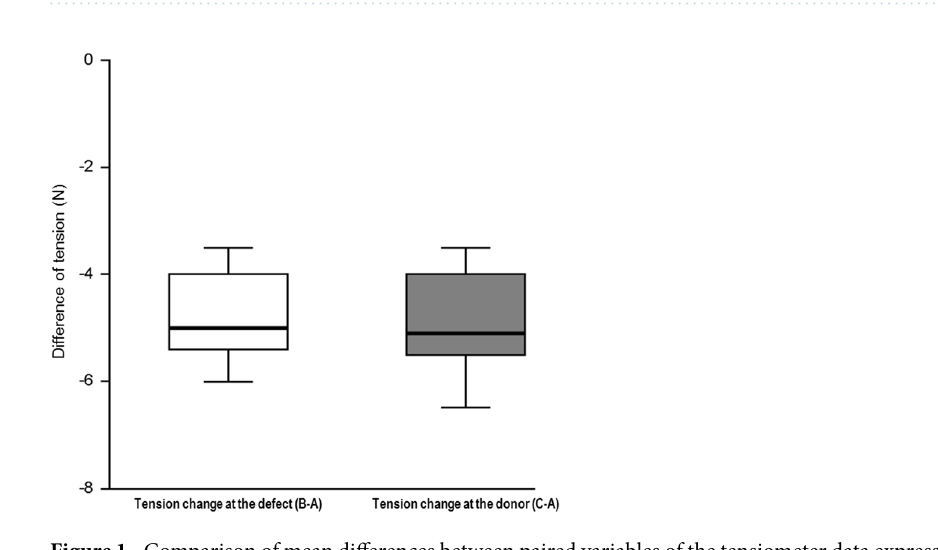
Figure 1. Comparison of mean differences between paired variables of the tensiometer data expressed as ¼ Q (first quartile), Median, ¾ Q (third quartile). A, pre-flap tension at the defect; B, post-flap tension at the defect; C, post-flap tension at the donor.